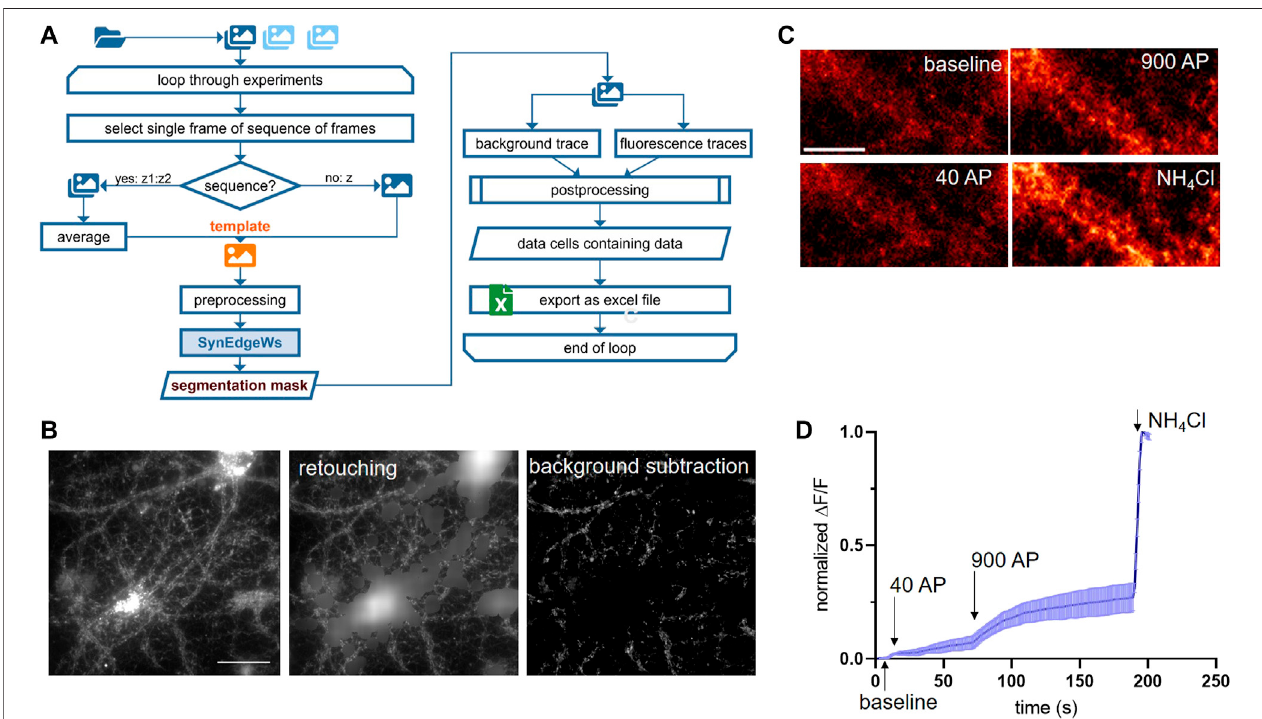
FIGURE3| ImgSegRoutfordetection andanalysisofsynapses inimage stacks. (A) FlowchartinAdepictsallstepsofImgSegRout. (B) Example ofpreprocessing of images during ImgSegRout. Here, images of neuronal cultures expressing SypmOr sensor for monitoring of SV recycling were processed. Shown are the raw image (left), image after retouching procedure (middle), and image after background subtraction (right). Scale bar is 40 µm. (C) Illustration of neurons from imaging experiment to monitor SV release. Shown are cells upon stimulation with 40 AP (20 HZ) and 900 AP (20 Hz), respectively, and the application of NH 4 Cl to alkalize SV and to visualize the total amount of SV. Scale bar is 15 µm. (D) Representative mean curve derived from three experiments. The data points represent the mean values of normalized MFI traces ( Δ F/F) with plotted error (SEM). In an experiment, normalized MFI values were calculated by averaging all traces derived from individual ROIs and by normalizing in the range of NH 4 Cl signal and baseline (F = F NH4Cl — F base ; Δ F = F frame — F base